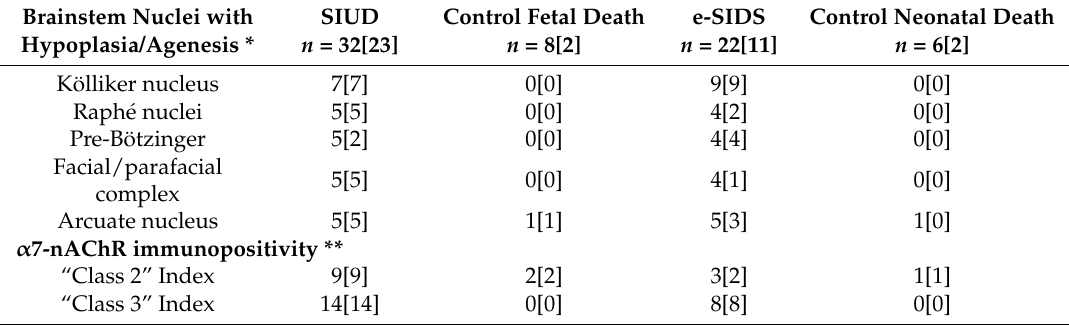
Table 2. Distribution of the brainstem morphological and α 7-nAChR alterations in SIUD, e-SIDS and control cases, related to maternal smoking.